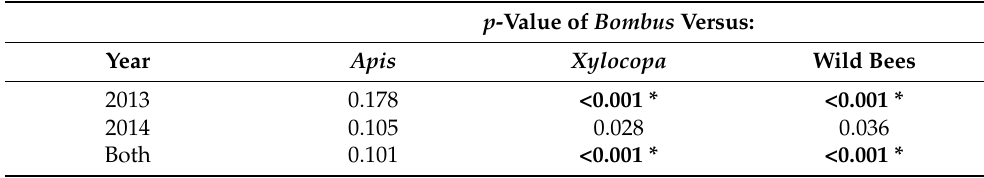
* Asterisks denote significance at the 5% level (after a Bonferroni correction for multiple